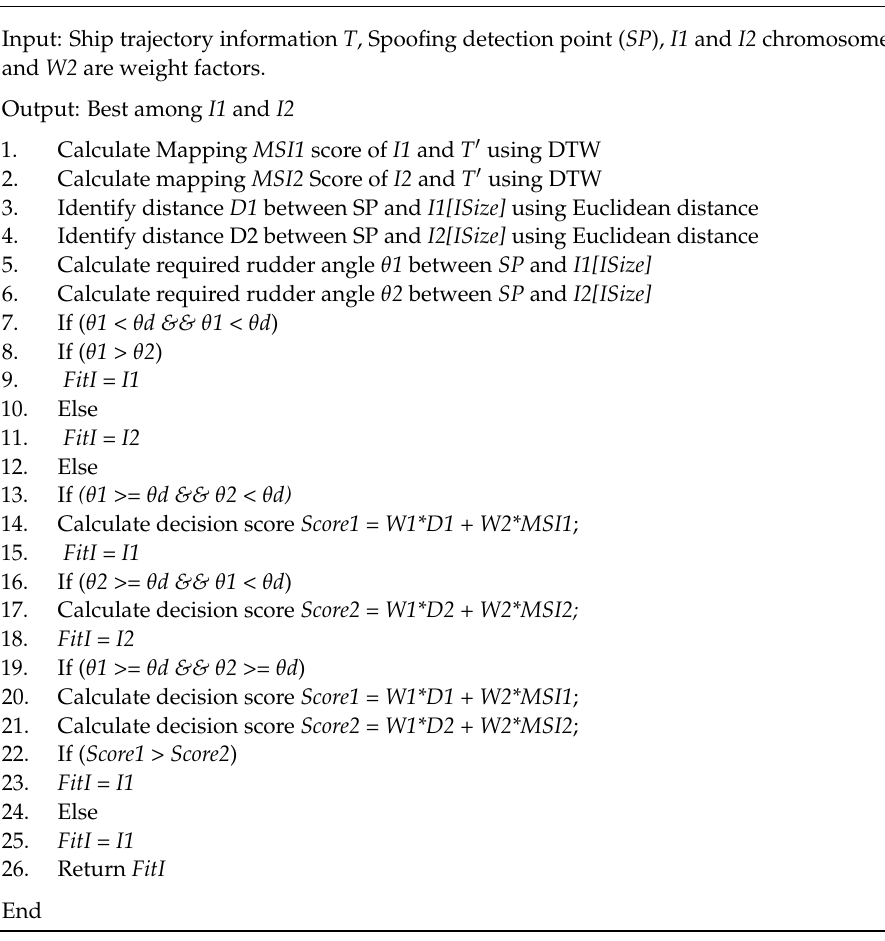
Algorithm 2 Fitness